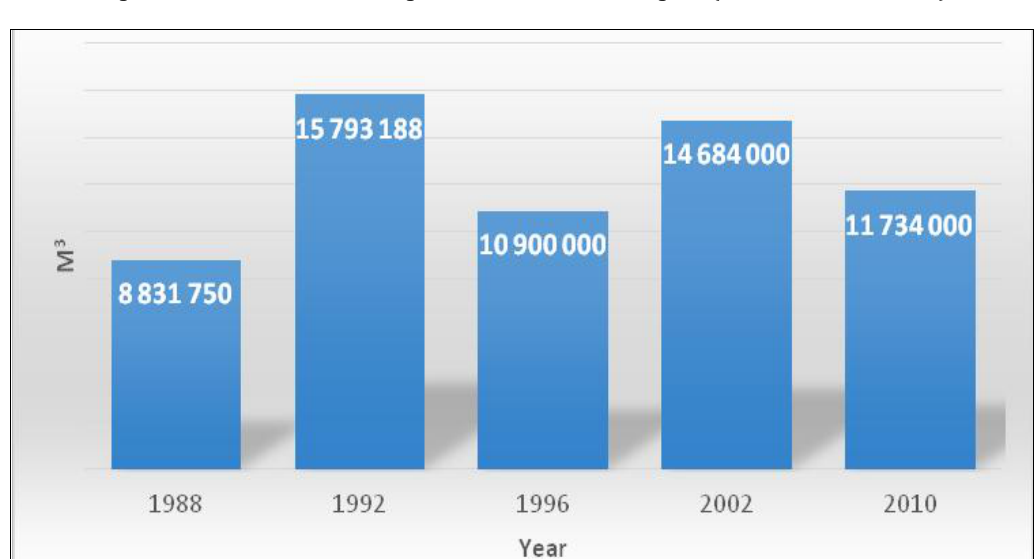
Fig. 1. Mass flow of wood waste generated in southwest Nigeria (after Oluoti et al., 2014)